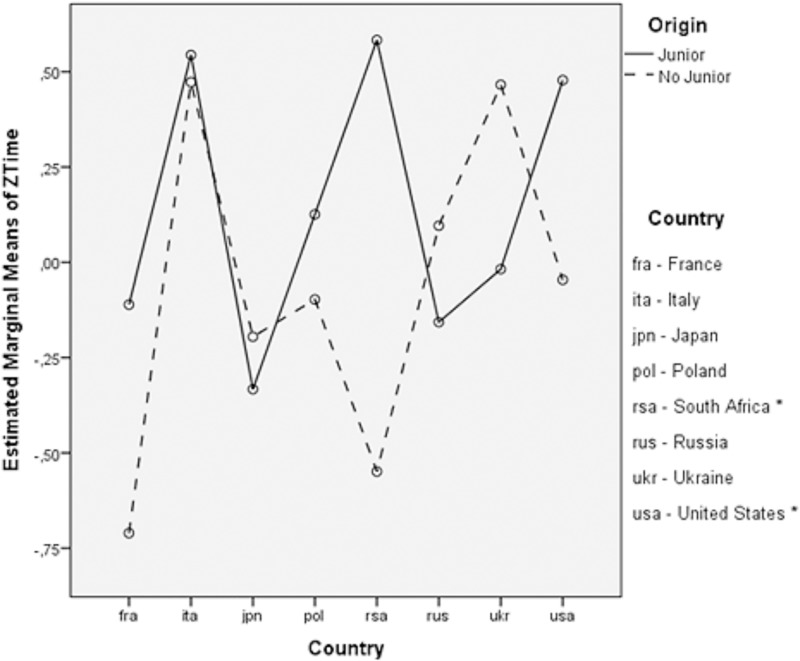
Cumulative percentage plots for Position in separate lines for Maintenance Years levels.